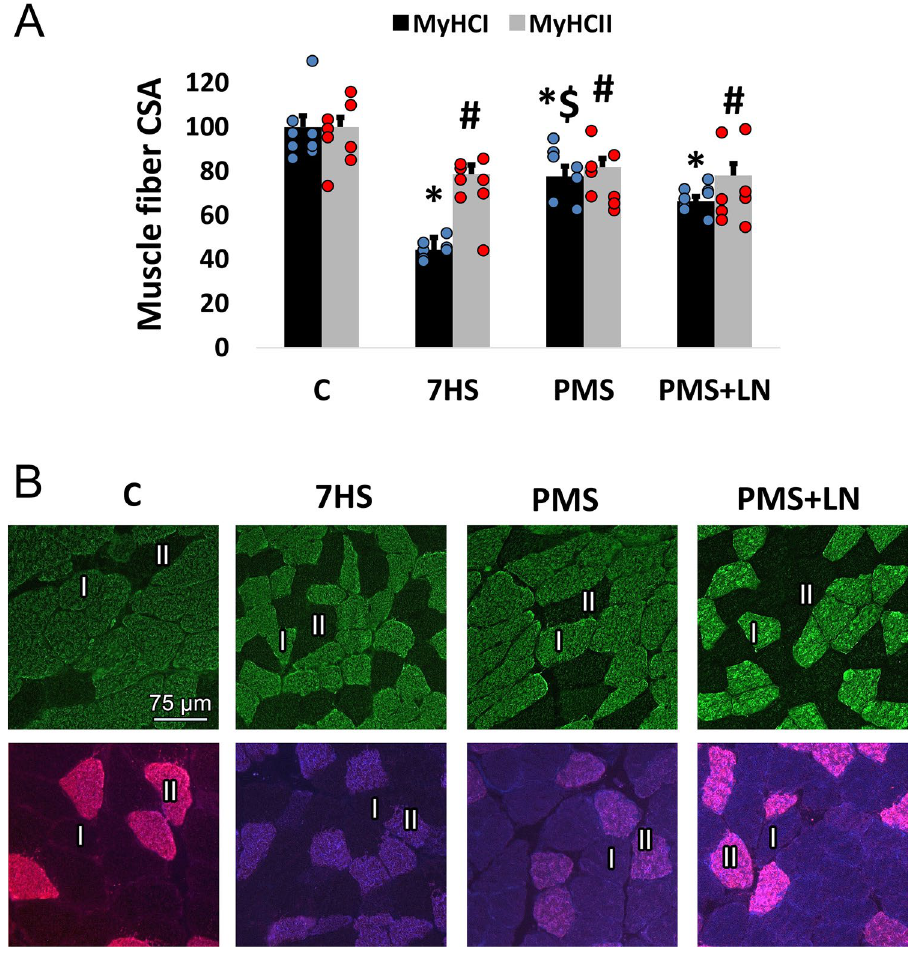
Figure 2. ( A ) Cross-sectional area of slow-type and fast-type fibres in the soleus muscle. ( B ) Representative images showing soleus muscle fibres expressing MyHC I and MyHC II. I—fibres expressing MyHC I; II—fibres expressing MyHC II. Control group (C); 7-days hindlimb-suspended group (7HS); 7-days hindlimb suspended group with plantar mechanical stimulation (PMS); 7-day hindlimb suspended group with plantar mechanical stimulation + L-NAME injection (PMS + LN). Data shown as % of control group. *Significant difference from control group for MyHC I. # Significant difference from control group for MyHC II. $ Significant difference from 7HS ( p < 0.05). Blue and red dots correspond to the number of samples. The cross-sectional area of slow-type and fast-type fibres was analyzed using ImageJ 1.52a software (https:// imagej. nih. gov/